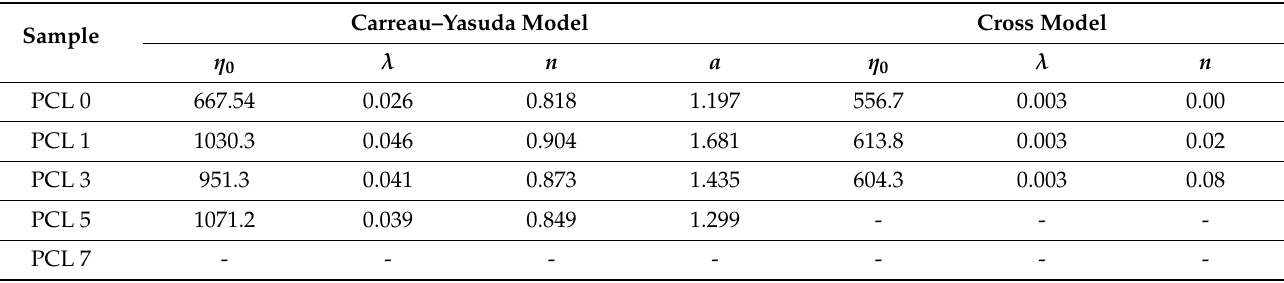
Figure 5. Complex viscosity modelling. ( a ) Carreau–Yasuda and ( b ) Cross model. Table 1. Carreau–Yasuda and Cross fitting parameters.